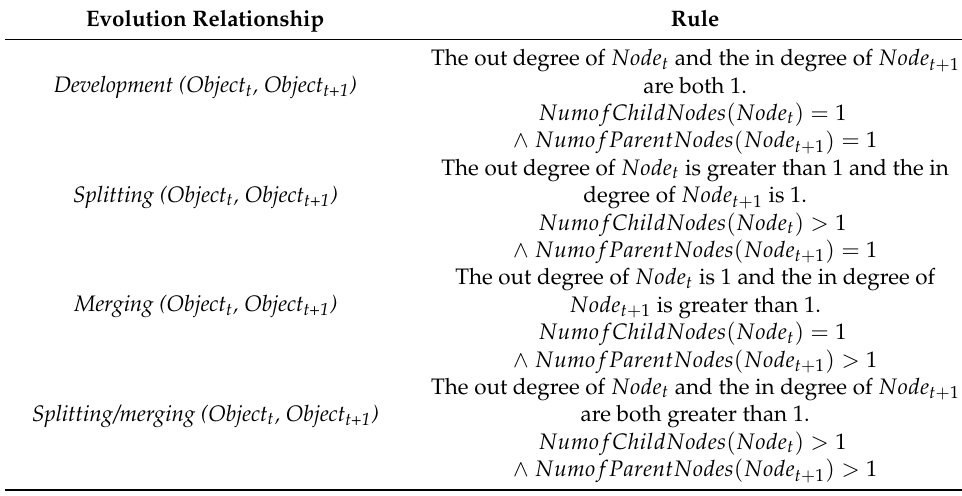
Table 1. Identification of four types of evolution